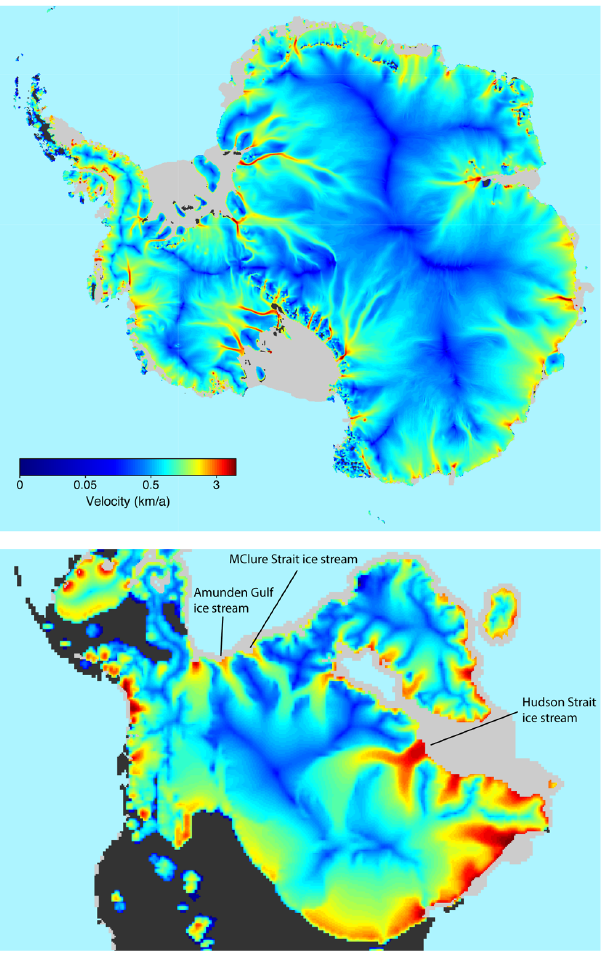
Fig. 1. Top: present-day Antarctic surface ice velocities obtained from the SeaRISE data website (Le Brocq et al., 2010). Bottom: Simulated Laurentide ice velocities during the last glacial maxi- mum. Light grey regions denote floating ice